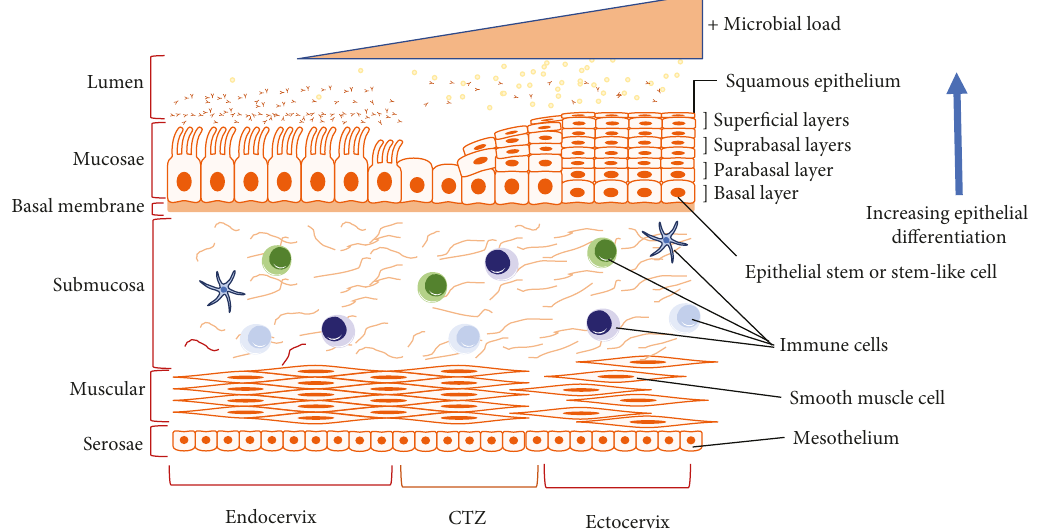
Figure 2: Microscopic illustration of the cervix. The cervix is divided into the two main compartments, namely, the microbe-laden ectocervix and “ sterile ” endocervix, which are bordered by the cervical transformation zone (CTZ) and their associated immune cells. The ectocervix (and vagina, not shown) has squamous strati fi ed epithelia, while endocervix (and uterus, not shown) has simple columnar